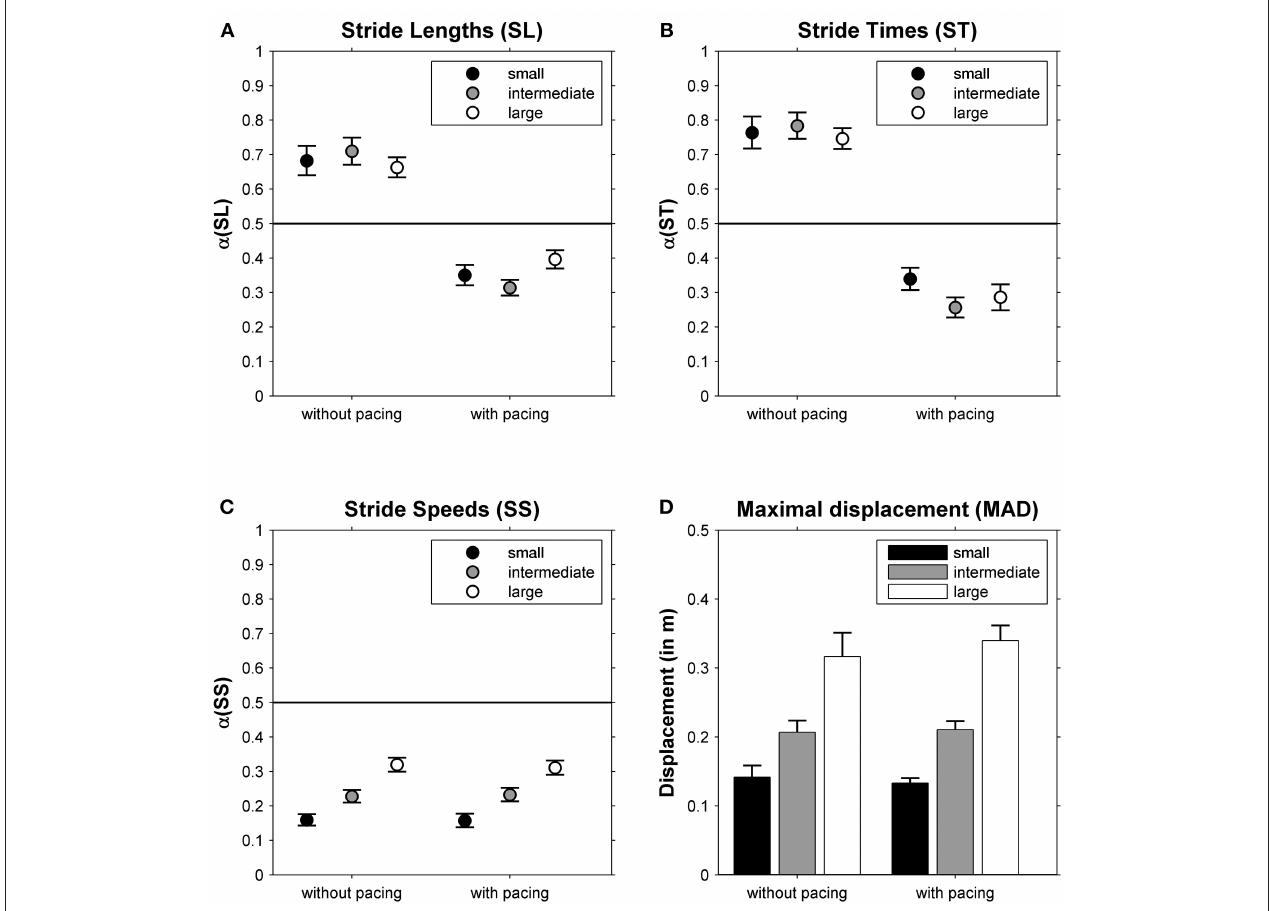
FIGURE 2 | The correlational structure of stride-to-stride fluctuations in stride lengths ( α (SL), A ), stride times ( α (ST), B ) and stride speeds ( α (SS), C ) is depicted as a function of Pacing and Walking Area. In (D) , the maximal absolute displacement along the treadmill is depicted for these conditions. Error bars represent standard